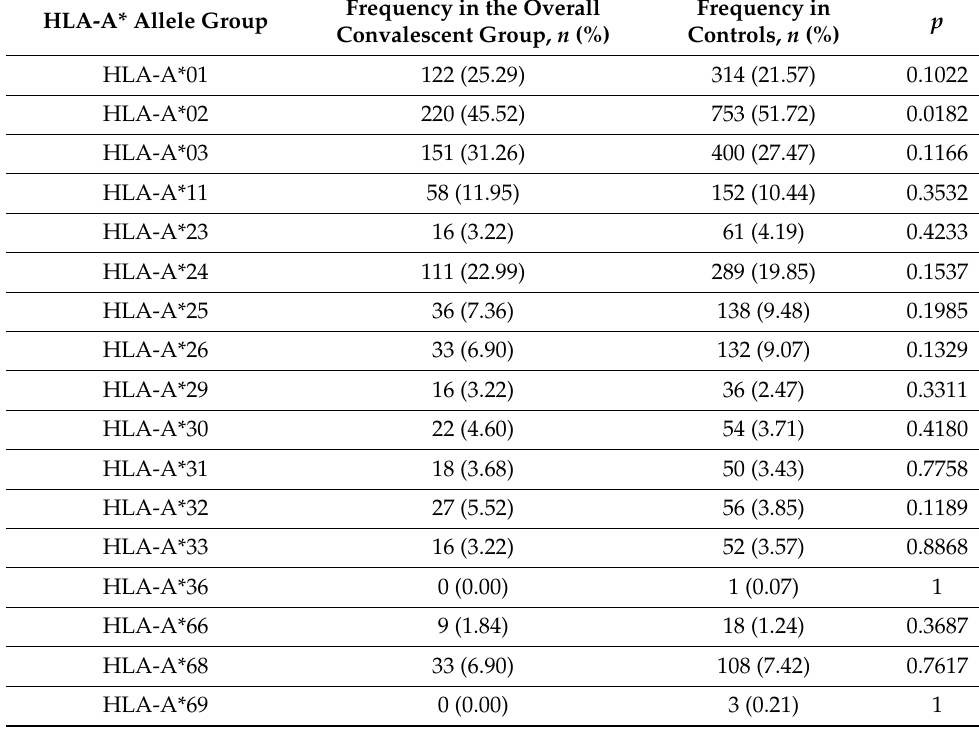
Table 1. Frequency of HLA-A* allele groups among the overall COVID-19 convalescent group ( n = 484) compared with controls ( n =